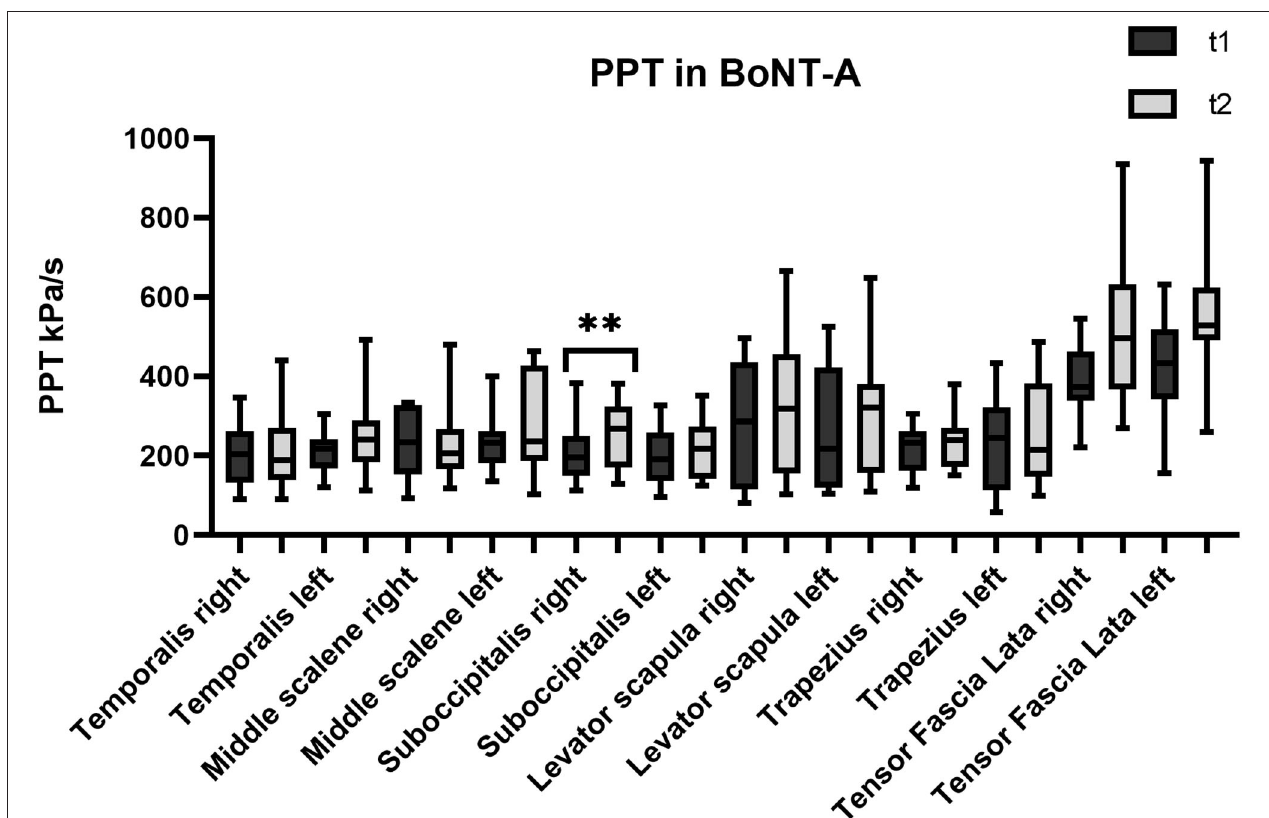
FIGURE 1 | Pressure pain threshold (PPT) over the trigeminal and extra-trigeminal area before (T1) and after (T2) onabotulinumtoxin-A (BoNT-A) treatment. * p value < 0.01.